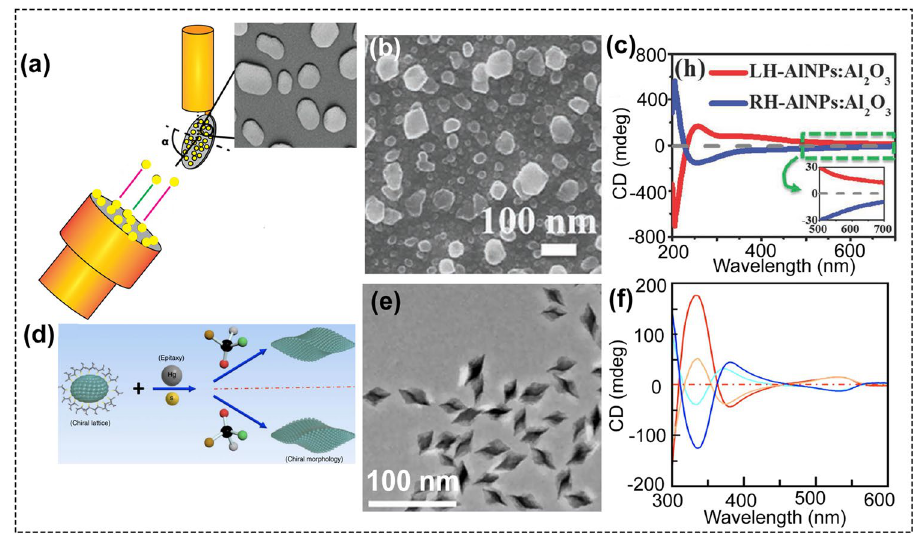
Fig. 1 a Scheme of the glancing angle deposition (GLAD). b TEM image and c CD spectra of the chiral Al nanostructures prepared by GLAD (reproduced with permission from Ref. [40]. Copyright 2013, Wiley). d Scheme of the wet-chemical method to synthesize chiral HgS nanostruc- tures. This method could allow the large-scale and cost-effective preparation of chiral nanostructures. e TEM image and f CD spectra of the chi- ral HgS nanostructures. Scale bar, 100 nm (reproduced with permission from Ref. [42]. Copyright 2017, Nature publishing